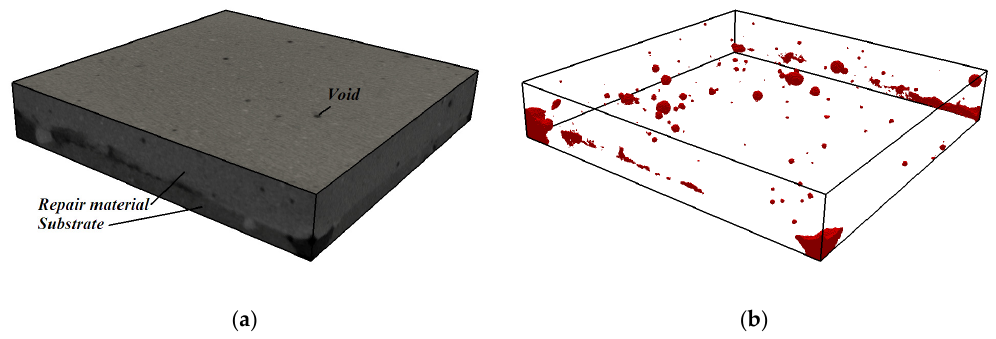
Figure 14. Void content in the repair system close to the interface, w/c = 0.3, DS, S3 (3mm thickness):